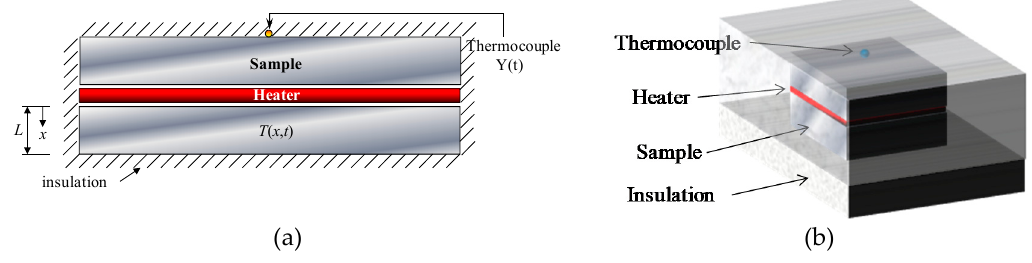
Figure 1. A one-dimensional (1D) representation of the model. ( a ) thermal model; ( b ) three-dimensional view of the thermal model.